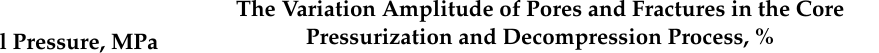
Table 2. The data table of the change amplitude of pores and fractures in the core during the pressurization and decompression process. The Variation Amplitude of Pores and Fractures in the Core Pressurization and Decompression Process, % Radial Pressure, MPa